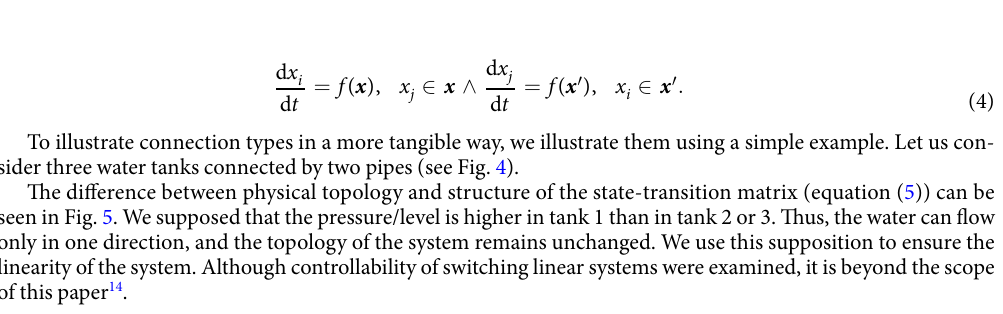
Figure 4. Physical representation of water tanks. State variables represent water levels in the tanks. Flow rates F 1 and F 2 show how the water flows through the pipes from the first tank into the